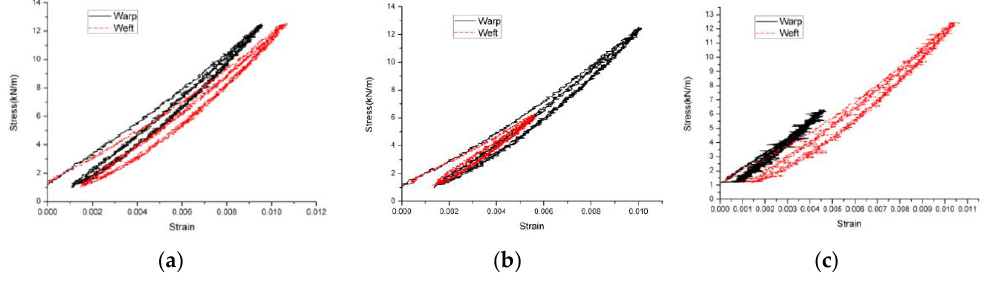
Figure 8. Cyclic curves of the stress and strain at each stress ratio. ( a ) 1:1. ( b ) 2:1. ( c ) 1:2.